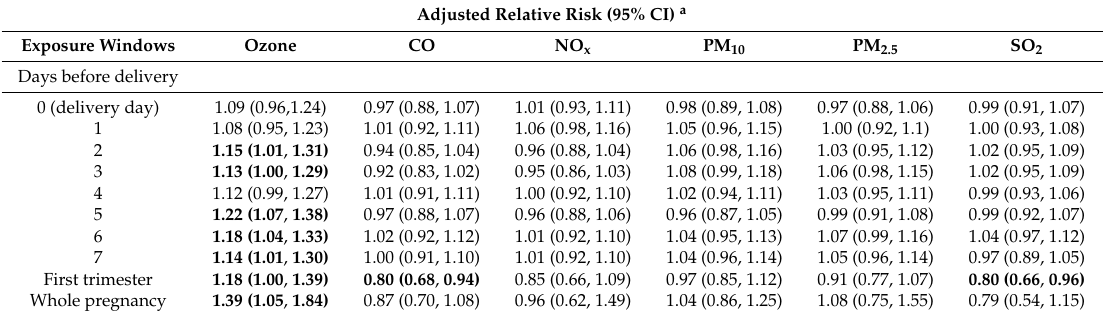
Table 2. Risk of stillbirth related to acute and chronic criteria air pollutant